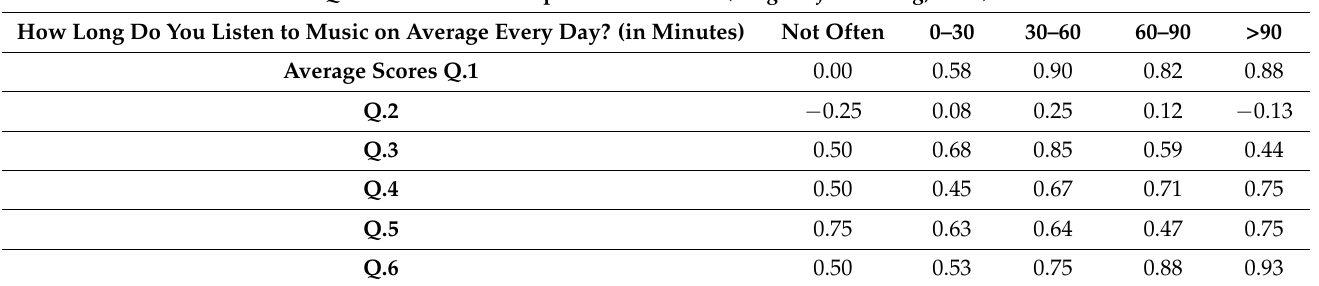
Table 3. Subjective evaluation score.